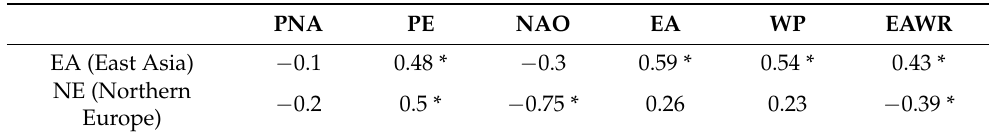
Table 3. The correlation coefficient between the PC time series of each teleconnection pattern and surface temperature (T2m) in East Asia (EA) and Northern Europe (NE) (an asterisk (*) indicates the statistical significance at the 95% confidence level). PNA